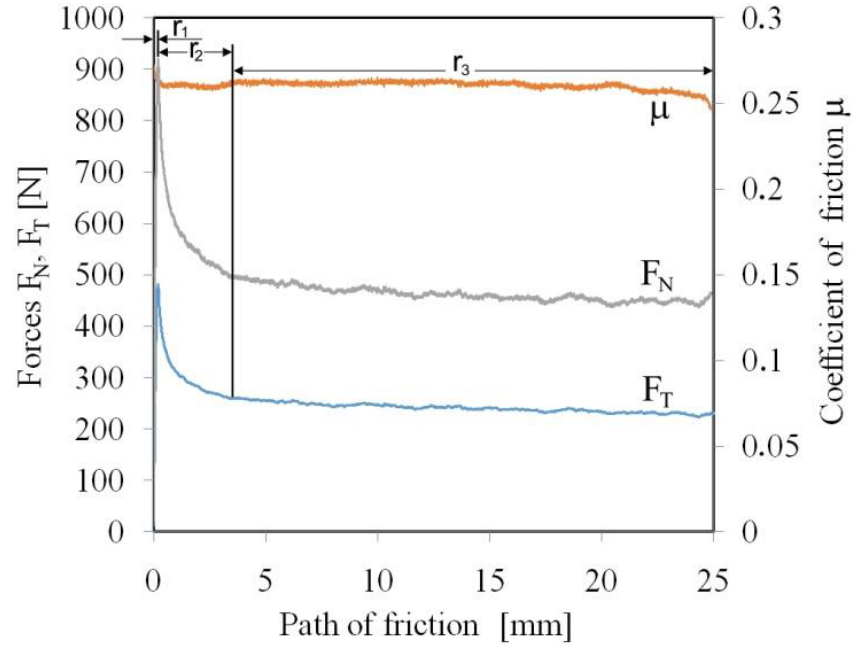
Figure 5. Variation of the friction force, normal force and coefficient of the friction during friction test (dry friction, p = 3 MPa).